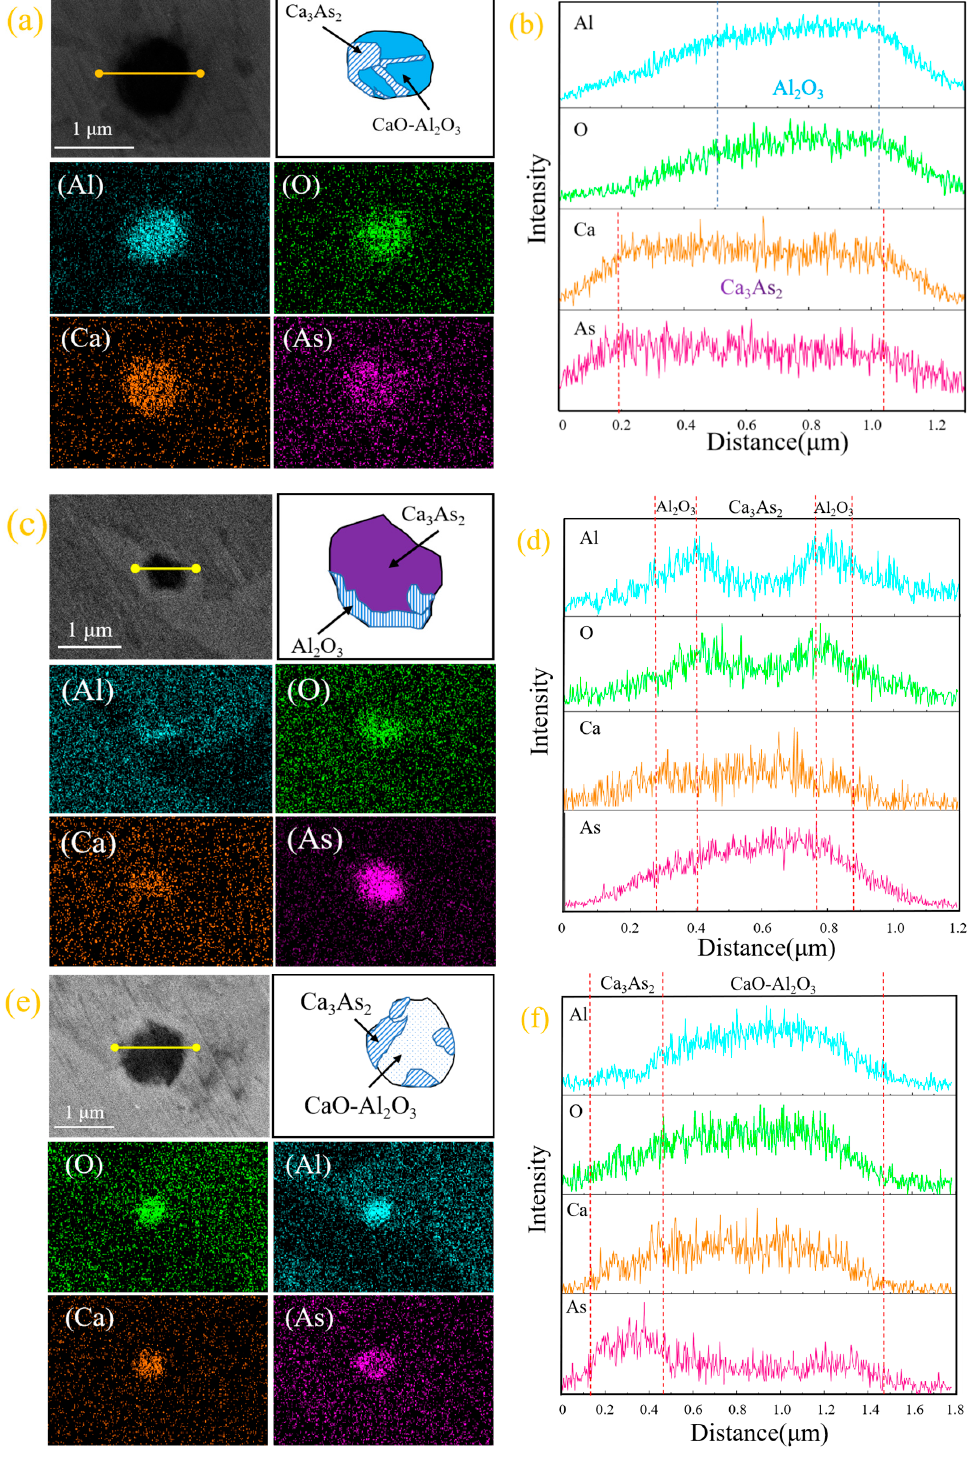
Figure 2. ( a , c , e ) Electron microscopy and morphology of inclusions; ( b , d , f ) line scan images of inclusions.